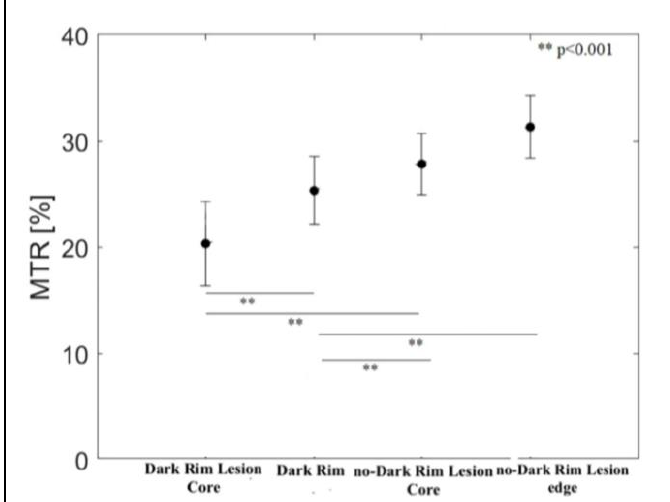
Figure 5. Comparison of mean MTR between DRLs (both core and rim), no-DRL core and edge, showing different MTR values across all the sampled data. MTR = magnetization transfer ratio; DRLs = dark rim lesions.